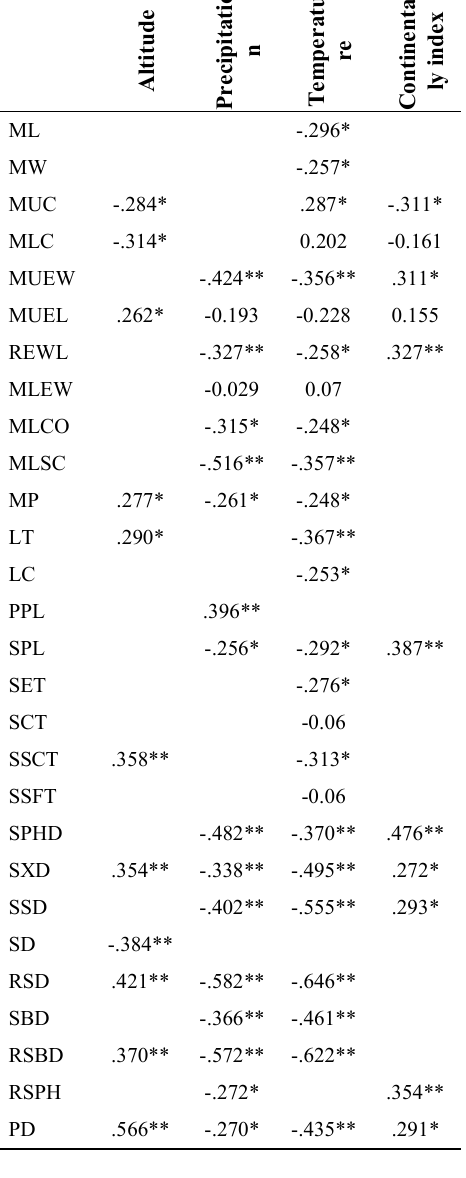
Table 3. Pearson correlation matrix between environmental variables and anatomical features of Carpinus orientalis: ML- Midrib length; MW- Midrib width; MUC- Midrib upper cuticle’s thickness; MLC- Midrib lower cuticle’s thickness; MUEW- Midrib upper epidermis width; MUEL- Midrib upper epidermis length; MLEW- Midrib lower epidermis width; MLCO- Midrib lower collenchyma thickness; MLSC- Midrib lower sclerenchyma thickness; MP- Midrib phloem’s length; LT- Lamina thickness; LC- Lamina lower cuticle’s thickness; PPL; Palisade parenchyma length; SPL- Spongy parenchyma length; SET- Stem cuticle thickness; SCT- Stem collenchyma thickness; SSCT- Stem epidermis thickness; SSFT- Stem sclerenchymal fiber thickness; SPHD- Stem phloem diameter; SXD- Stem xylem diameter; SSD- Stem stele diameter; SD- Stem diameter; RSD- SSD / SD; RSBD- SBD / SD; RSPH- SPHL / SSD; PD- Petiole diameter